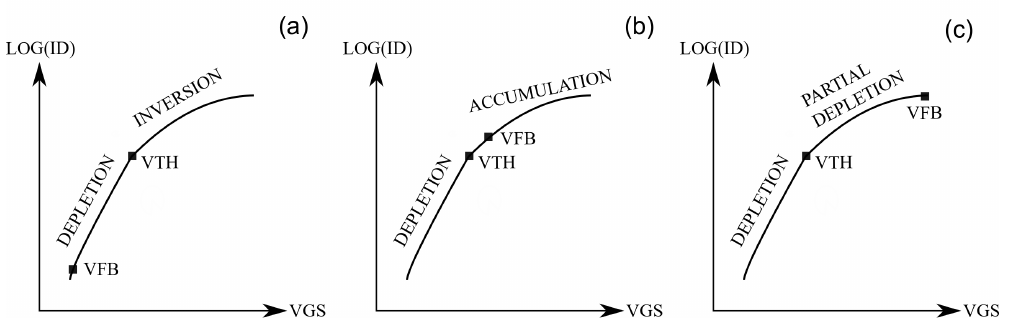
Figure 3. Current behavior in ( a ) inversion mode (IM), ( b ) accumulation mode (AM), and ( c ) junctionless